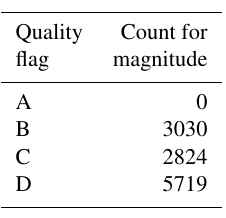
Figure 10. Timeline of the 6575 recomputed M S (bottom) for the relocated extension events during 1920–1959 and their an- nual counts (top). 2304 earthquakes have M S < 5 . 5 and 80 have M S ≥ 6 . 5. Table 3. Summary of the magnitude quality flags for the relocated extension events between 1920 and 1959. Included in the D flag are 4984 events for which no magnitude was